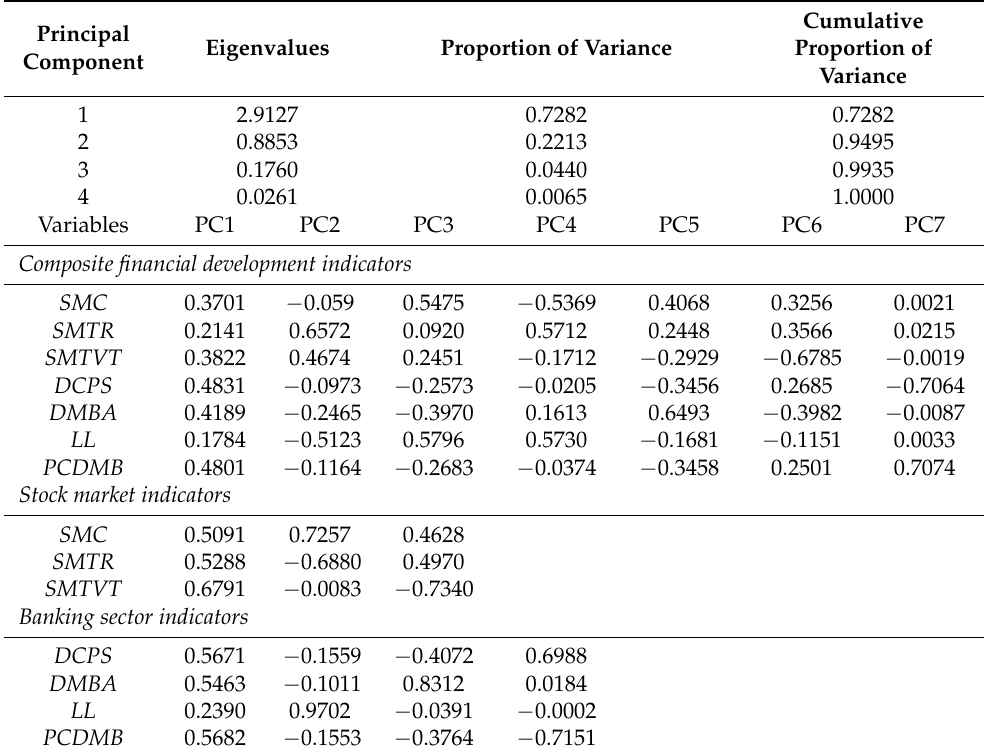
Table 2 represents the descriptive statistics and Spearman’s rank correlation coeffi- cients of variables. It shows that in OECD countries, the average CO 2 emissions per capita are approximately 8.635 metric tons, the average ratio of renewable energy consumption to total energy consumption is approximately 16.707%, and the average ratio of renew- able electricity output to total electricity output is approximately 28.734%. By comparing financial development indicators, we find that the degree of the banking sector is higher on average than that of the stock market. Figures 2 and 3, respectively, present the heat maps of renewable electricity output and CO 2 emissions for 37 OECD countries. It can be seen that Iceland and Norway have a higher ratio of renewable electricity output to total electricity output. Luxembourg and the United States have higher CO 2 emissions per capita. According to the results of the correlation coefficients in Table 2, both renewable energy consumption and renewable electricity output are significantly negatively corre- lated with CO 2 emissions, indicating that the use of renewable energy may help enhance banking sector development are all significantly positively correlated with CO 2 emissions, suggesting that CO 2 emissions will rise as the financial market improves. In addition, the significant positive relation between other control variables and CO 2 emissions suggests that higher economic growth, higher urbanization, higher globalization, and a more stable environment will also increase CO 2